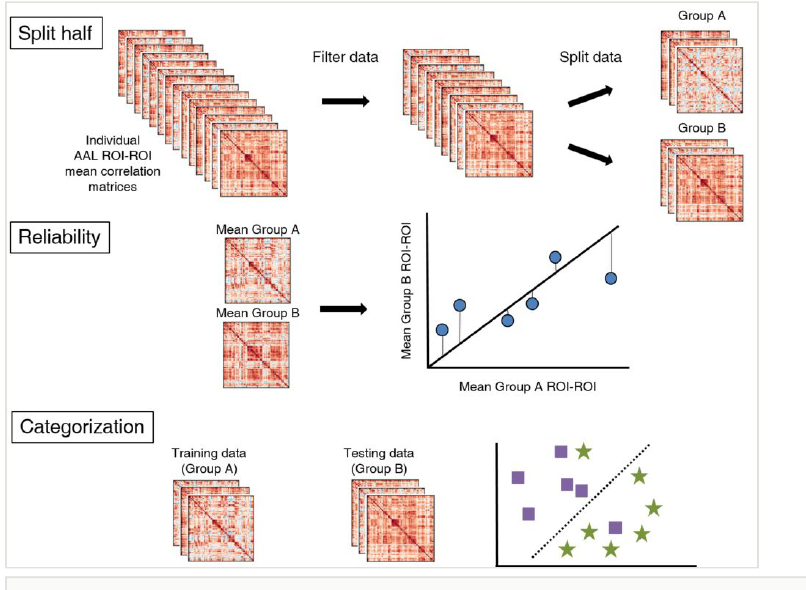
In order to investigate the e ff ects of age range, motion exclusion threshold and sample size on functional connectiivity reliability we split the data into two matched samples. For the reliability analysis we averaged all participants in each sample and then calculated how well aligned the two groups were in terms of each pairwise regional connectivity measure. For the out-of- sample prediction analysis we used one half of the data to train a model and then tested it on the other